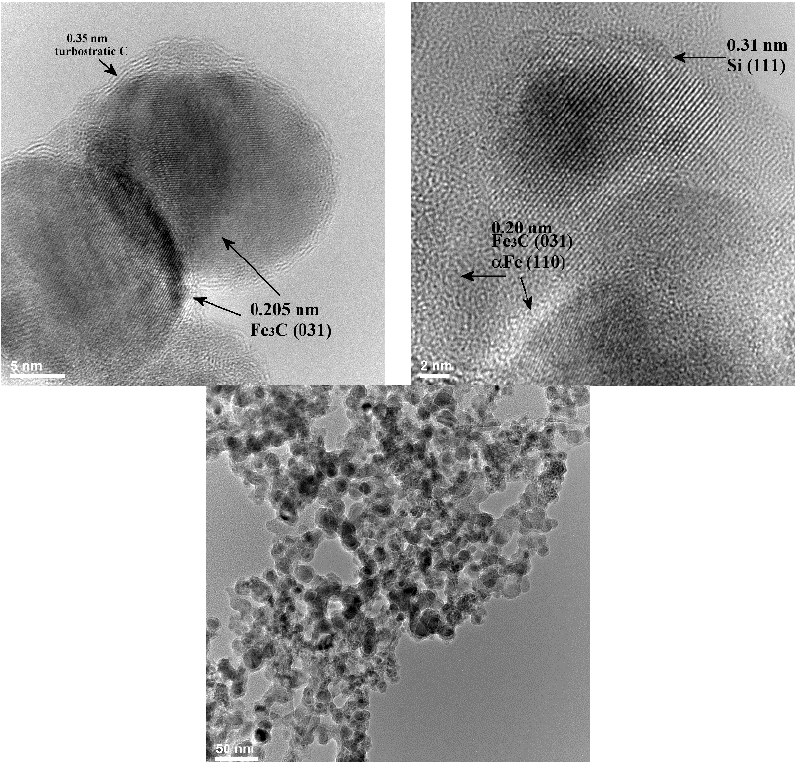
Figure 3. Higher definition (left: Fe-Si3, center: Fe-Si7 samples) and lower definition (right: Fe-Si7 sample) TEM images of nanoparticles from as-synthesized powders.